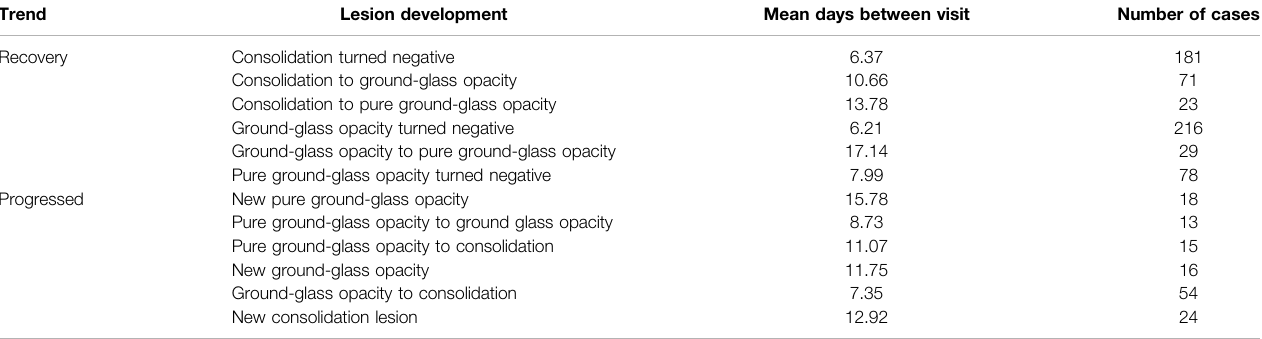
TABLE 2 | Comparison of time and clinical data between different outcome groups. Trend Lesion development Mean days between visit Recovery Consolidation turned